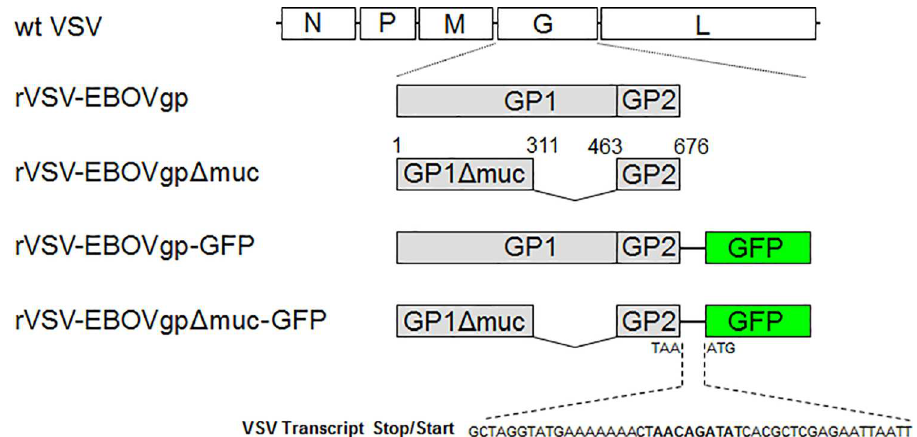
Fig 1. Schematic representationof recombinant vesicularstomatitis viruses(rVSV) containingthe EBOV GP and greenfluorescentprotein (GFP). The VSV genomecodes for the nucleoprotein (N), phosphoprotein(P), matrix(M),glycoprotein (G),and polymerase (L) genes. Viruseswere rescuedin BSR-T7cells co-transfected with plasmidscoding for N, P, and L, and plasmidscontaining the wild-type VSV (wt VSV) genomeor constructsthat replacethe VSV-G gene for the full-lengthEBOV GP (rVSV-EBOVgp), mucin-like domaindeletedEBOV GP (rVSV-EBOVgp Δ muc),EBOV GP followed by GFP (rVSV-EBOVgp- GFP, or mucin-deleted EBOV GP followed by GFP (rVSV-EBOVgp-GFP). The mucin-deleted EBOV GP containsamino acid residues1–311 and 463–676of EBOV GP. A VSV transcription stop/startsignal (bold characters) was molecularly cloned between the GP and GFP genes to drive the expression of